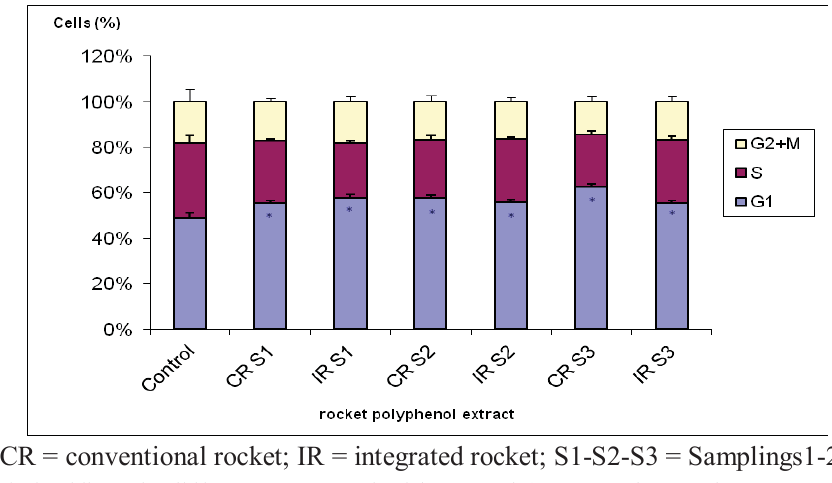
Figure 2. Effect of 10 mL/L rocket polyphenol extract on cell cycle # .